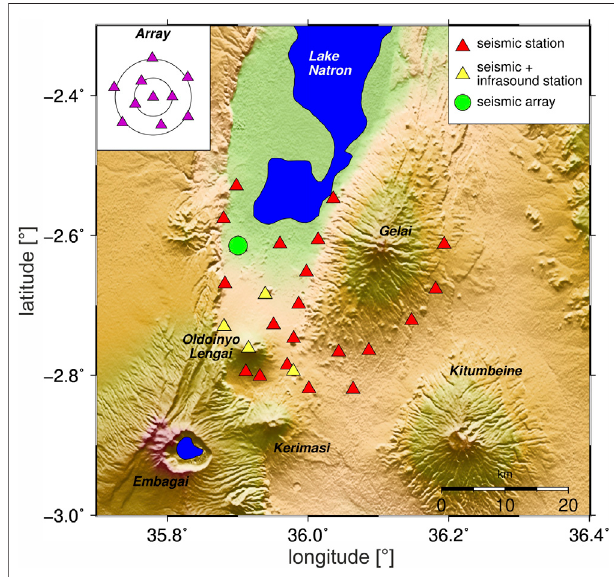
FIGURE 2 | Seismic stations are red triangles, and co-located seismic and infrasound stations are yellow triangles. The green circle denotes the seismic array which is shown in the upper left corner. Volcanoes are written in bold black